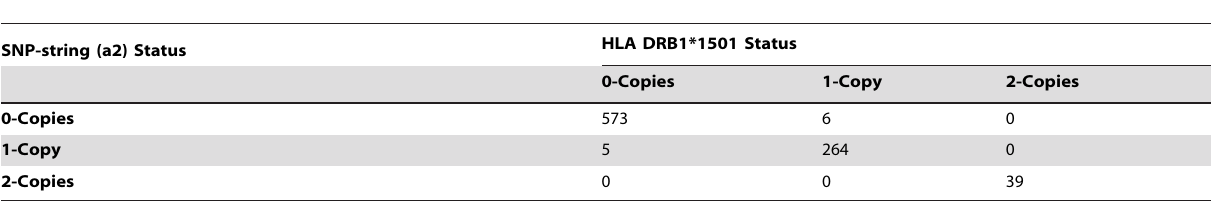
Table 9. Contingencies for HLA DRB1* Status and (a2)-haplotype Status from SNP-String Phasing